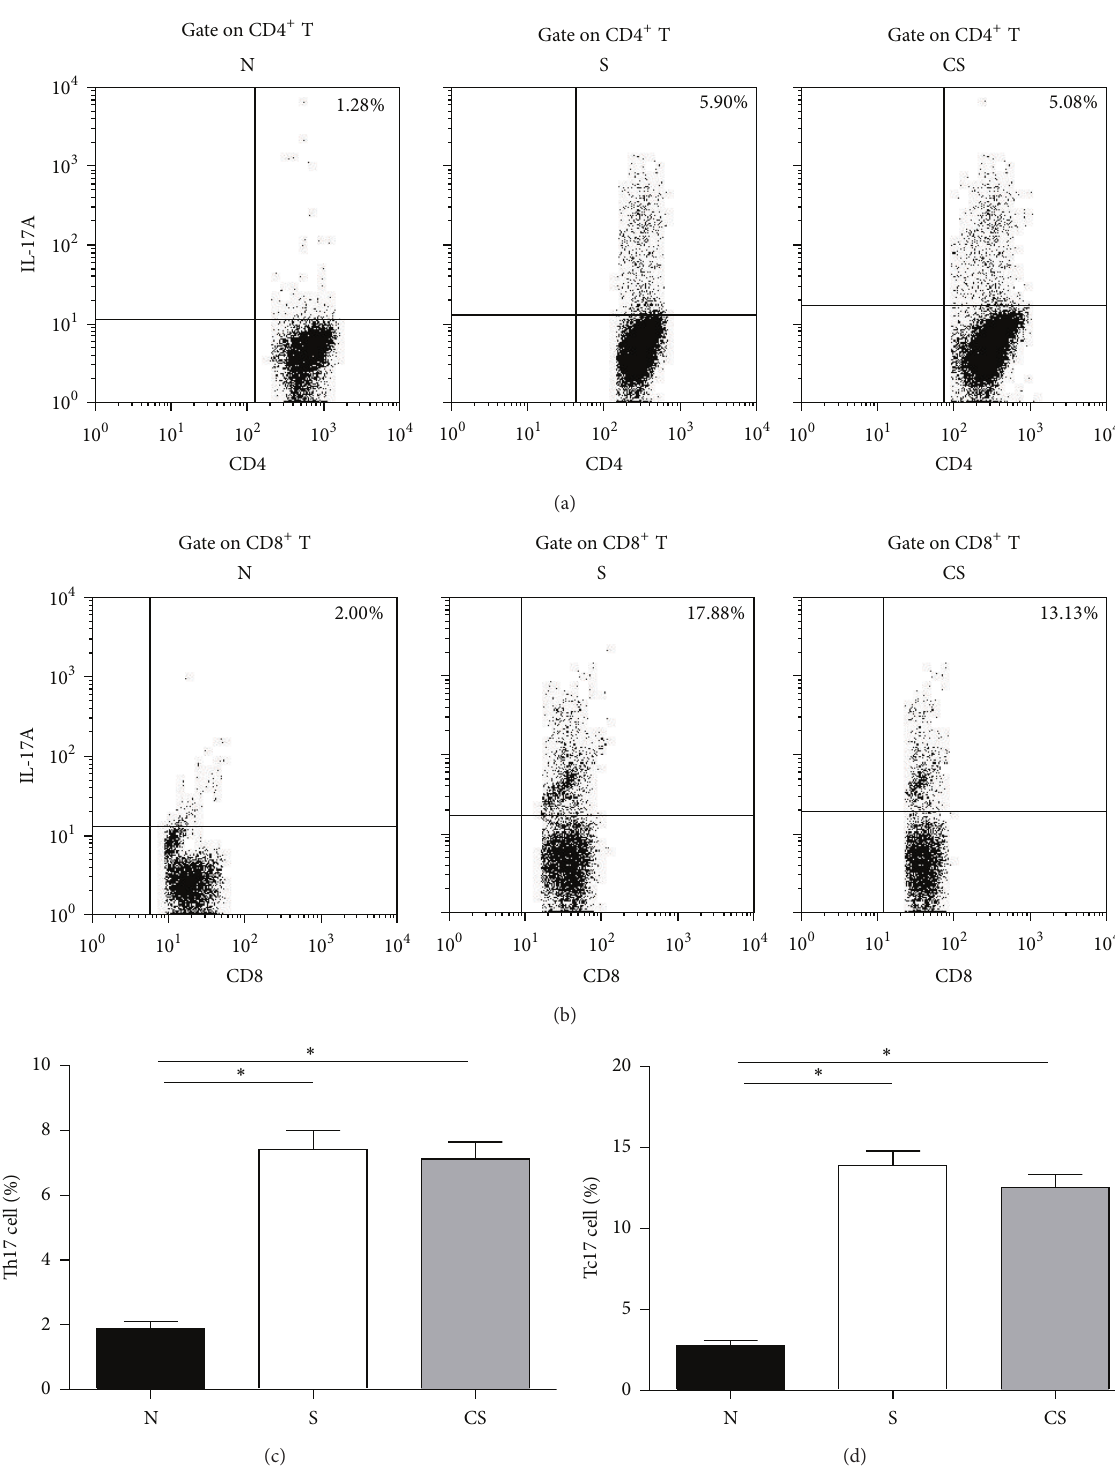
Figure 3: Increased numbers of CD 4 + IL- 17 + (Th17) cells and CD 8 + IL- 17 + T (Tc17) cells are not reversible after smoking cessation.Lung single-cell from nonsmoke mice, smoke-exposed mice, and smoke cessation mice was stimulated by PMA and ionomycin for 4h and analyzed IL-17A by using flow cytometry. (a) Representative FACS staining for IL-17A in gated CD 4 + T cells. (b) Representative FACS staining for IL- 17A in gated CD 8 + T cells. (c) The frequencies (%) of Th17 cells; (d) the frequencies (%) of Tc17 cells. Results are expressed as % (mean ± SEM). 𝑛 = 10 animals/group; ∗ 𝑃 < 0.05